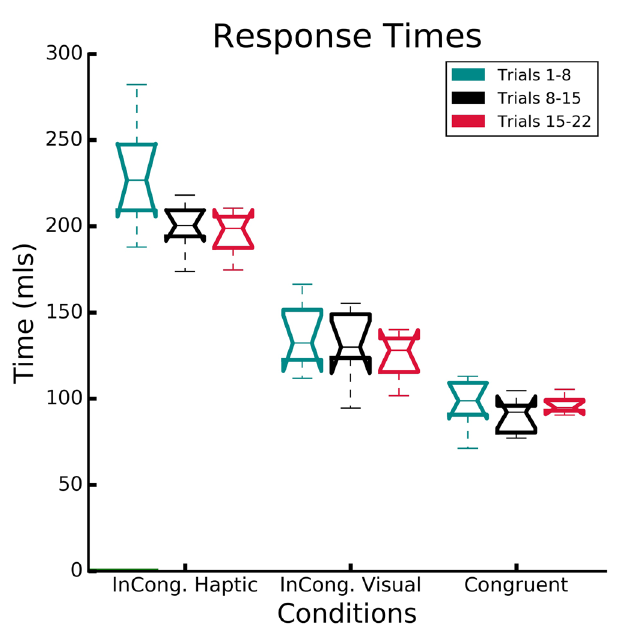
Figure 7. Normalized RTs responses for the three conditions binned in windows of 7 trials (1–8: early trials, 8–15: middle trials, 15–22: late